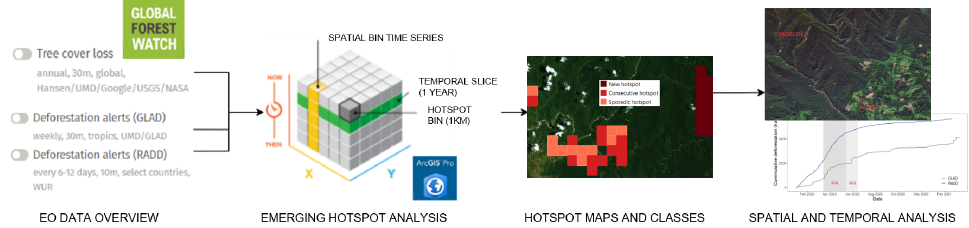
Figure 2. Four main steps of the